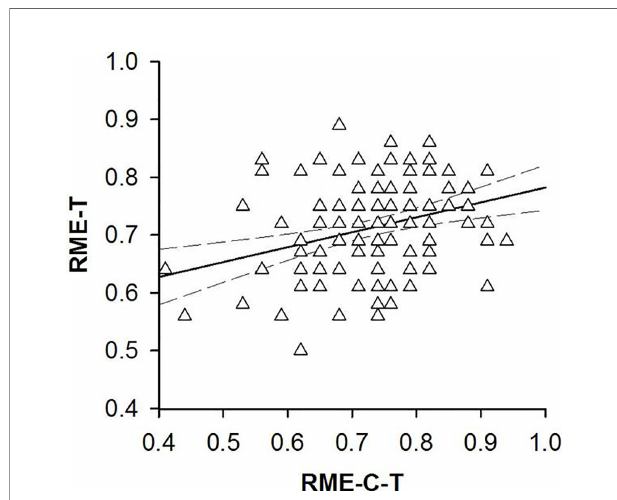
FIGURE 3 | Scatterplots with lines of best fi t demonstrating correlations between participants ’ performance on the Reading the Mind in the Eyes of Children Test [RME-C-T, (23)] and participants ’ performance on the Reading the Mind in the Eyes Test [RME-T,